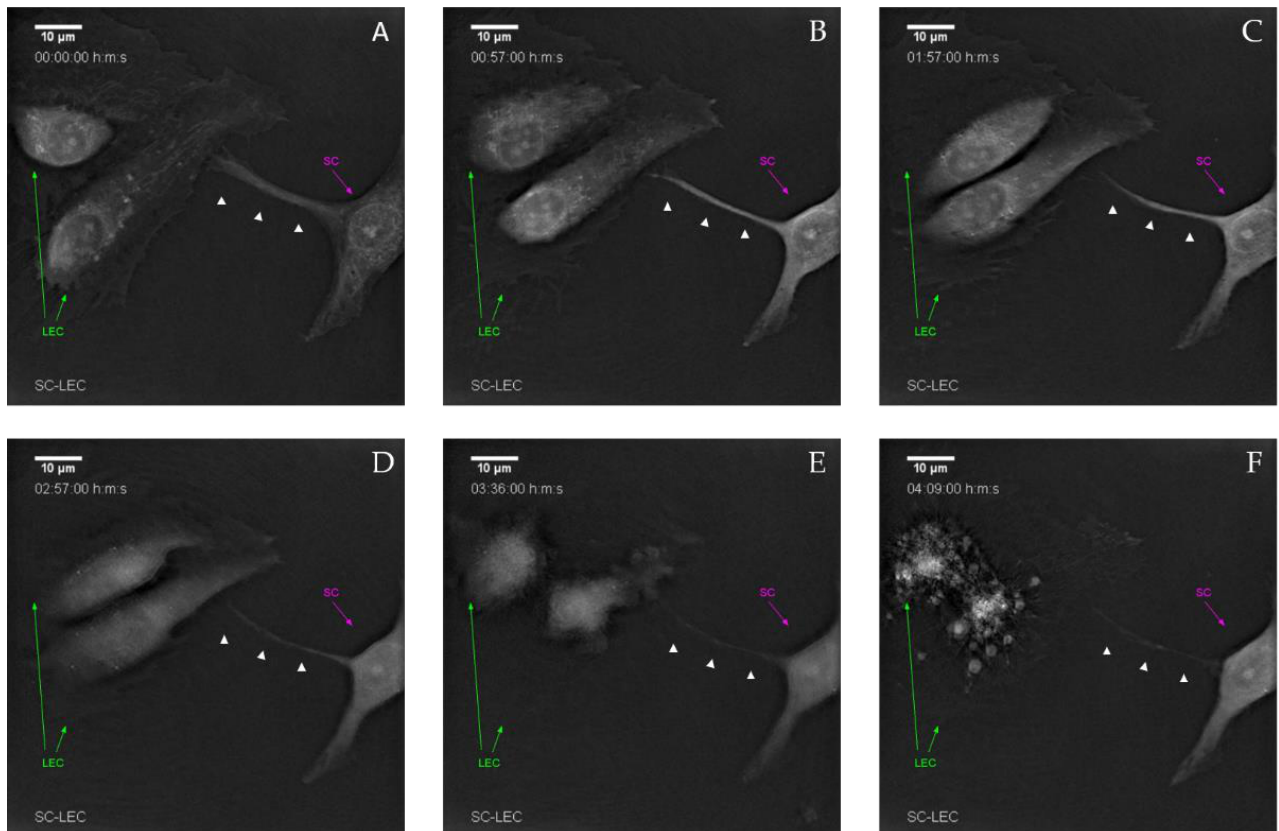
Figure 7. Live cell imaging demonstrates that cell–cell contact induced lymphatic endothelial cell death by Schwann cells. ( A ) Initial cell–cell contact between LECs (green arrow) and SCs (magenta arrow) via filopodia-like protrusions (white arrow heads). ( B ) After initial contact, morphological changes in both LECs and the SC-filopodia-like protrusions become visible. ( C , D ) Retraction of both the filopodia-like protrusion and LEC endoplasm. ( E ) Stark retraction and compartmentalization of LECs. ( F ) Formation of LEC-derived apoptotic bodies. Time-lapse shown in each image is the observation time starting 2 h post-seeding. Interestingly, stimulation with TNF- α also induced changes in SC morphology, es- pecially when cultured together with LECs and ASCs. In the presence of TNF- α , SCs manifested a multipolar morphology, with highly branched protrusions (Figure 9). This phenotype was not observed in unstimulated